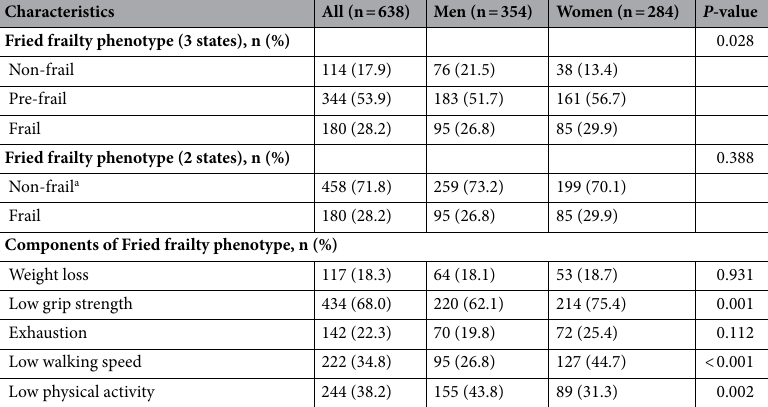
Table 3. Fried frailty phenotype and its components according to sex. Categorical variables are described as frequencies (n) and percentages (%). Comparisons were conducted using the chi-square test. a The non-frail and pre-frail groups were pooled together in one non-frail